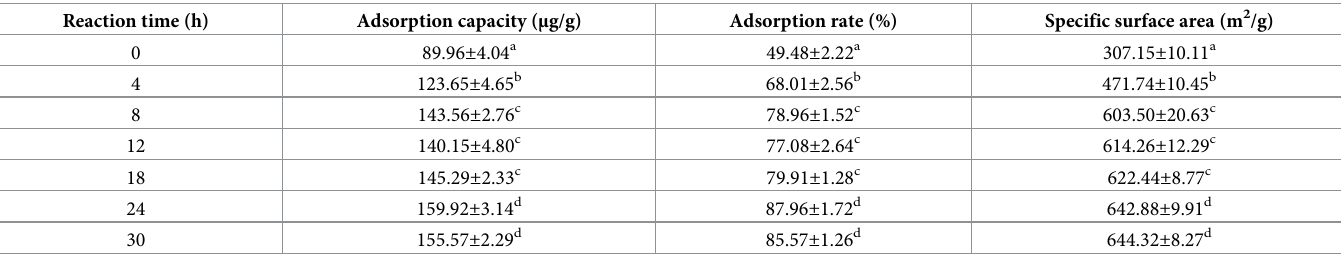
Table 2. Effect of reaction time on the specific surface area and adsorption to AFB1 of MMS.